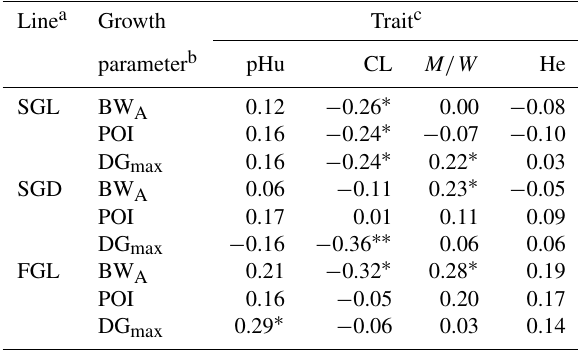
Table 6. Residual Pearson product-moment correlation coefficients between Gompertz–Laird growth curve parameters and breast meat quality traits by